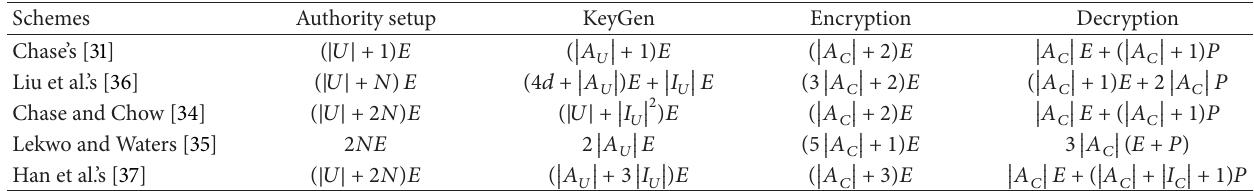
Table 5: Comparison of computing